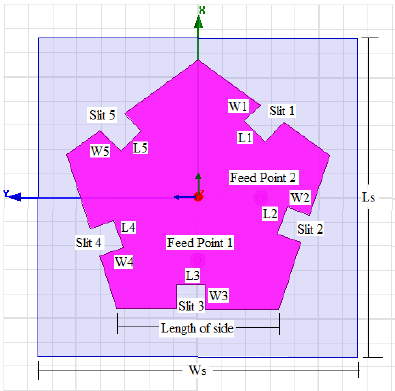
Figure 1. Proposed CP Pentagonal Microstrip Antenna (Feed Point 1 = (- 13, 0) mm, Feed Point 2 = (0, -13) mm)